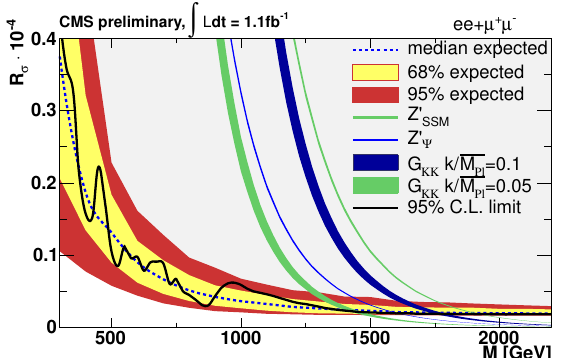
Fig. 4. Upper limits on the production ratio R σ of cross section times branching fraction into lepton pairs as a function of reso- nance mass, for Z (cid:48) , Z (cid:48) , and G KK . The limits are shown from ψ SSM the combined dilepton ( ee + µ + µ − ) result. Shaded yellow and red bands correspond to the 68% and 95% quantiles for the expected limits. The predicted cross section ratios are shown in bands, with widths indicating theoretical